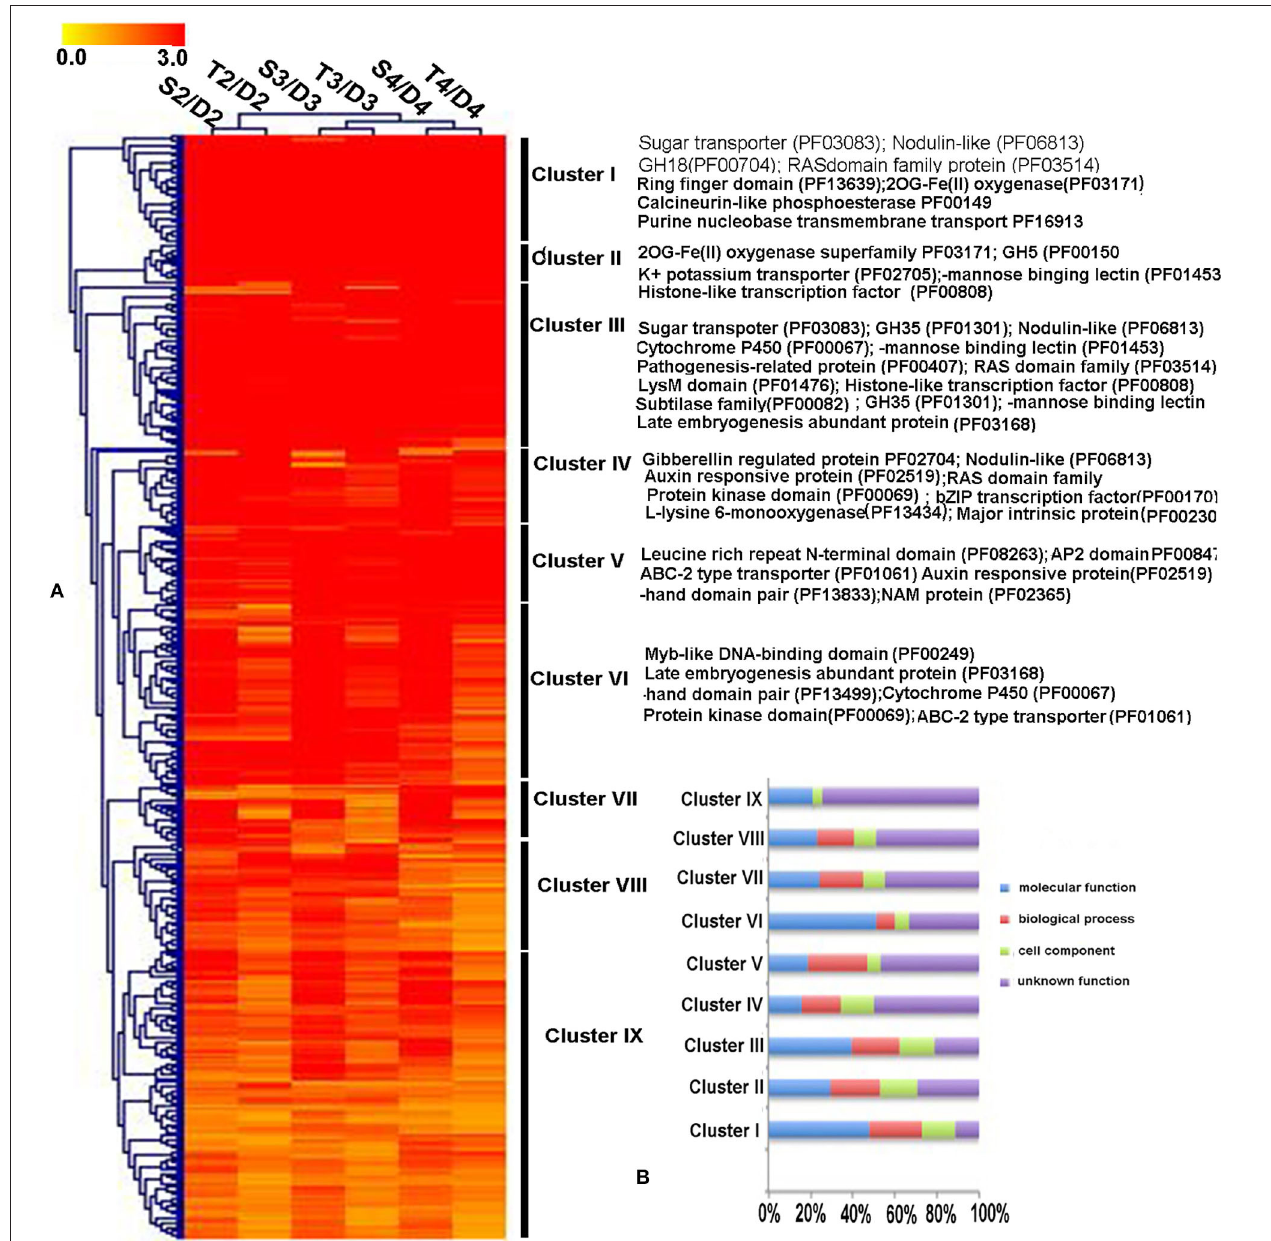
FIGURE 3 | The expression patterns and functional classification of 452 differentially upregulated expressed plant genes (DEGs) at least one symbiotic stage during D. officinale inoculated two mycorrhizal fungi. (A) Heatmap showing the expression level of up-regulated genes in symbiotic germination of D. officinale. Expression value was calculated based on Log 2 Fold change. Red color means a gene with a high expression value (Fold change ≥ 8) and yellow color means a gene with a relatively low expression value (Fold change ≥ 2). The function annotation of the representative genes with high expression (Cluster I-Cluster VI) was marked in the heatmap right. (B) GO functional category of the 452 up-regulated genes in nine clusters. D2, D3, and D4 mean asymbiotic germination stage2, stage3, and stage4, respectively; S2, S3, and S4 mean stages 2, 3, and 4 in symbiotic germination with Serendipita sp., respectively, T2, T3, and T4 means stages 2, 3, and 4 in symbiotic germination with Tulasnella sp., respectively. The detailed information of these genes is in Supplementary Table S1 .